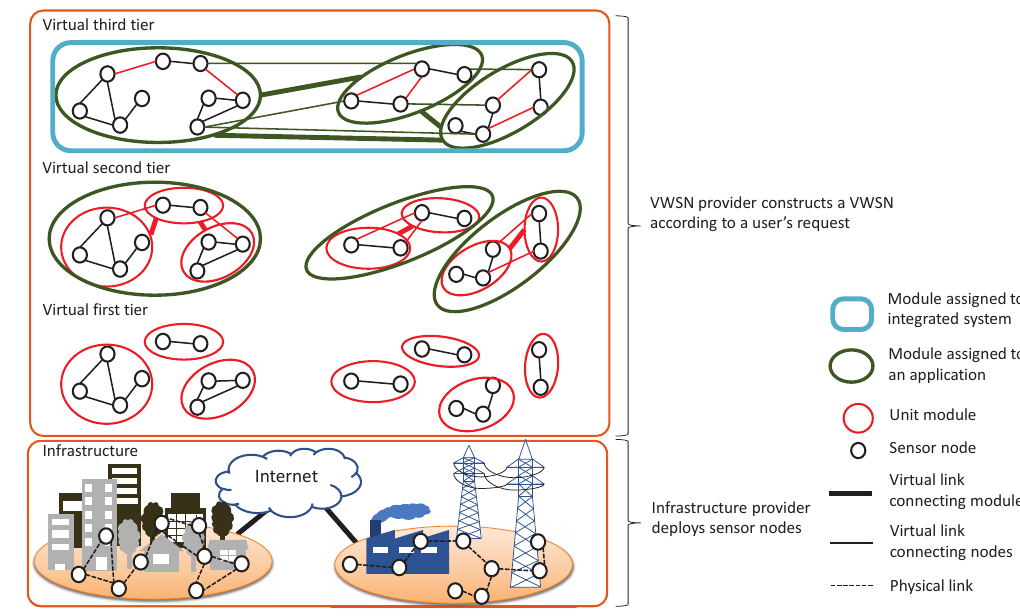
Figure 2. Example of a hierarchical VWSN